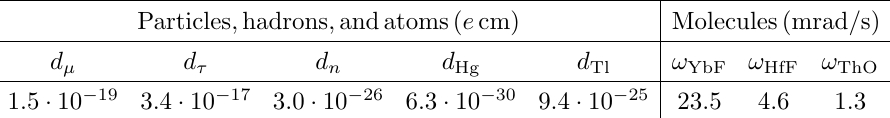
Table 3 . Current experimental limits (at 90% C.L.) from measurements on the muon [115], tau [14], neutron [116, 117], 199 Hg [118, 119], Tl [120], YbF [121, 122], HfF [123], and ThO [124{126]. Particles ; hadrons ; nuclei ; and atoms ( e cm)